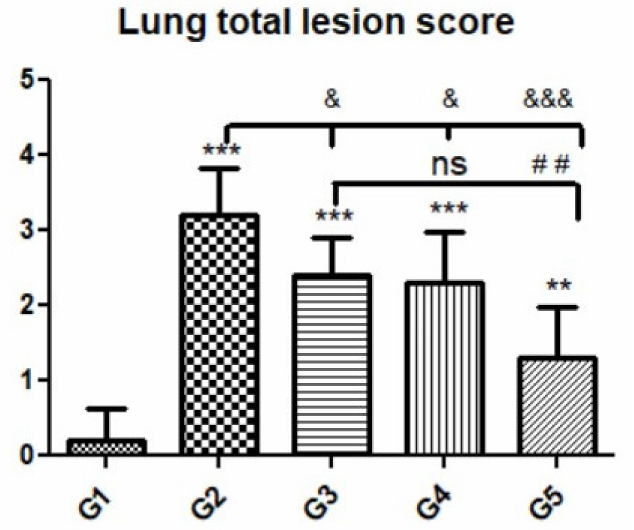
Figure 10. Quantitative and semiquantitative measurements of total lesion scores in lung tissue sections among the experimental groups. Data are expressed as the mean ± standard deviation. Significant differences (control group vs. other groups) are indicated by asterisks *, G2 vs. G3, G4, and G5 are marked by #, and G3 vs. G4 and G5 are marked by &. All tests were one-way ANOVA with Tukey’s post hoc test: ns: non-significant,**, ##, p ≤ 0.01, ***, &&& p ≤